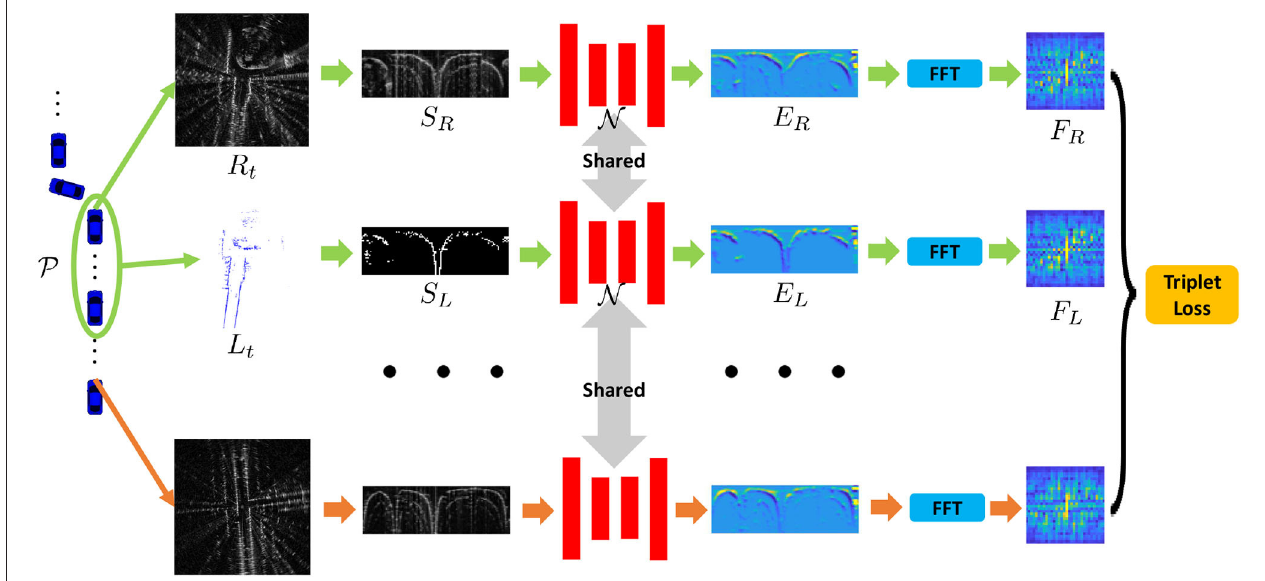
FIGURE 2 | Our proposed framework to train the joint place recognition for radar and lidar data. The first and second rows indicate that the radar scan and the lidar submap are collected from the same place, while for the last row, it is regarded as a negative sample in the learning stage.